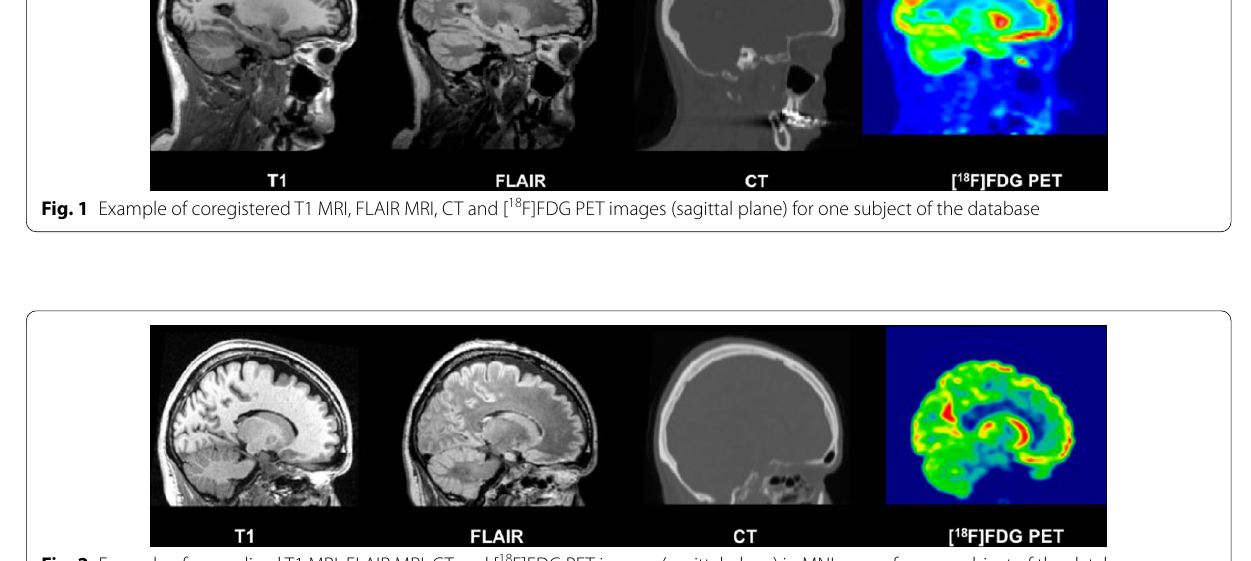
Fig. 2 Example of normalized T1 MRI, FLAIR MRI, CT and [ 18 F]FDG PET images (sagittal plane) in MNI space, for one subject of the